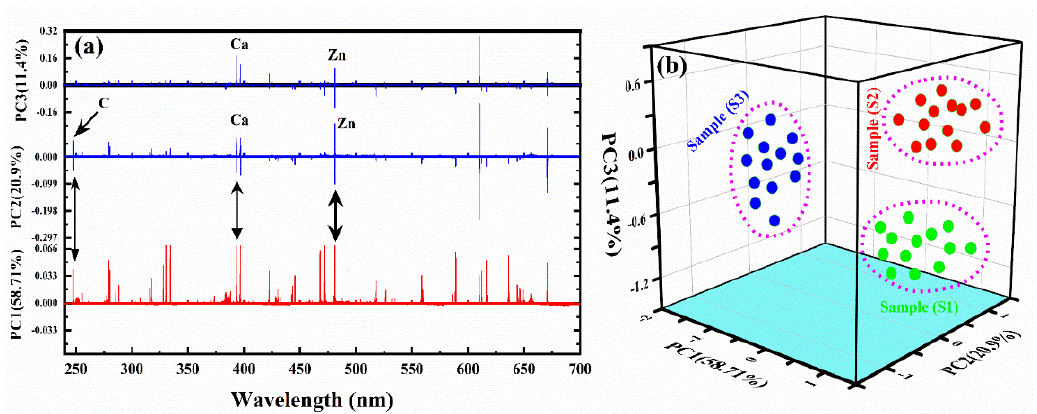
Figure 7. ( a ) The loading plots of the first 3 PCs, ( b ) 3D plot of the intensity of Zn (I) at wavelength 481.05 nm, Ca (II) at wavelength 393.37 nm, and C (I) at wavelength 247.86 nm for S1, S2, and S3,